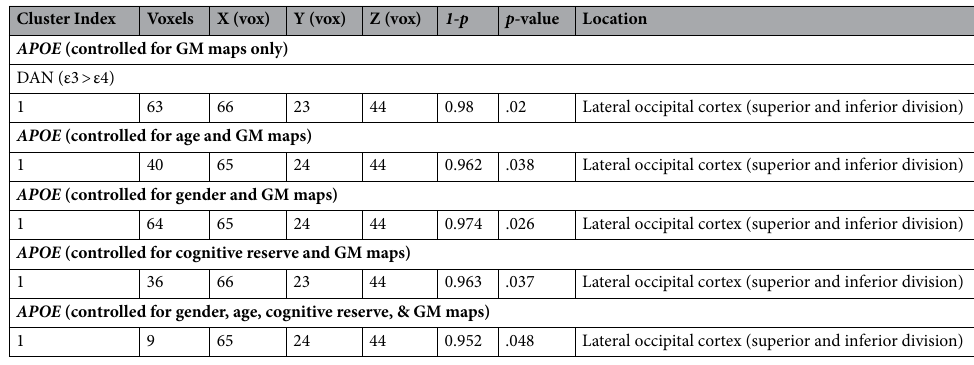
Table 2. Apolipoprotein E ( APOE ) results of analyses after running dual regressions using GLMs. GLMs = General Linear Models; DAN = Dorsal Attention Network; APOE = Apolipoprotein E; ε3 = ε3ε3 homozygotes; ε4 = ε3ε4 carriers; GM = Grey